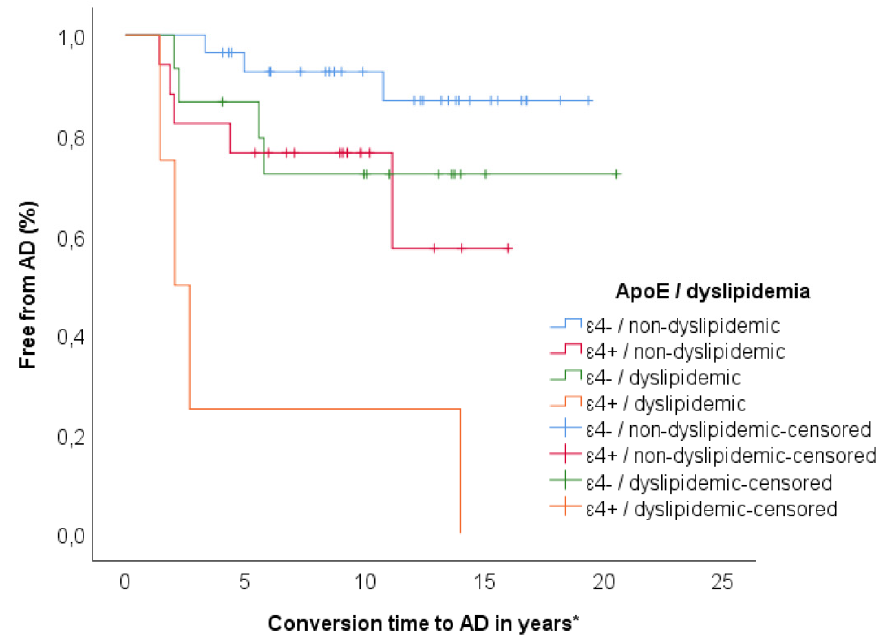
Figure 2. Kaplan–Meier survival analysis for comparisons of patients ranked according to history of dyslipidemia and ApoE genotype (non-dylipidemic / ε 4 − , n = 29; dyslipidemic / ε 4 − , n = 17; non-dylipidemic / high / ε 4 + , n = 15; dylipidemic / ε 4 + , n = 4). Proportion of progression was higher in dylipidemic / ε 4 + (100.00%) compared to non-dylipidemic / ε 4 − (10.30%, χ 2 = 25.47, p < 0.001), non-dylipidemic / ε 4 + (29.40%, χ 2 = 4.42, p = 0.036), and dylipidemic / ε 4 − (26.7%, χ 2 = 7.64, p = 0.006). Proportion of progression in non-dylipidemic / ε 4 + group (26.7%) was higher than non-dylipidemic / ε 4 − (10.3%, χ 2 = 3.73, p = 0.05). * For censored cases (non converters) conversion time indicates follow-up time.